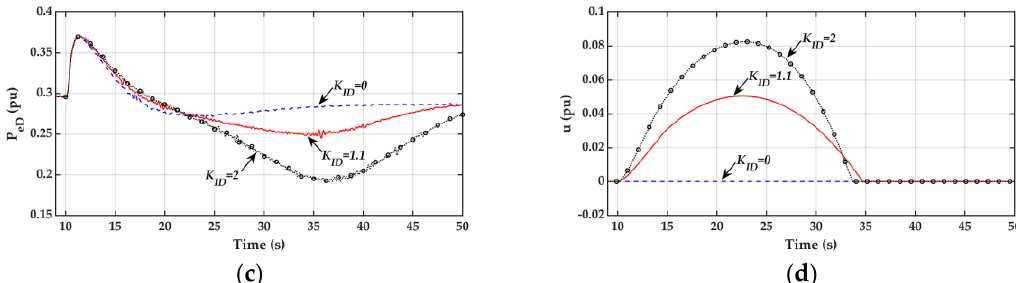
Figure 9. Comparison of dynamic response curves from different integral gains ( K PD = 20, P grid = 45 MW, V w = 11 m/s). ( a ) Frequency, ( b ) DFIG speed, ( c ) DFIG electrical power, ( d ) deactivation function based integral control signal.